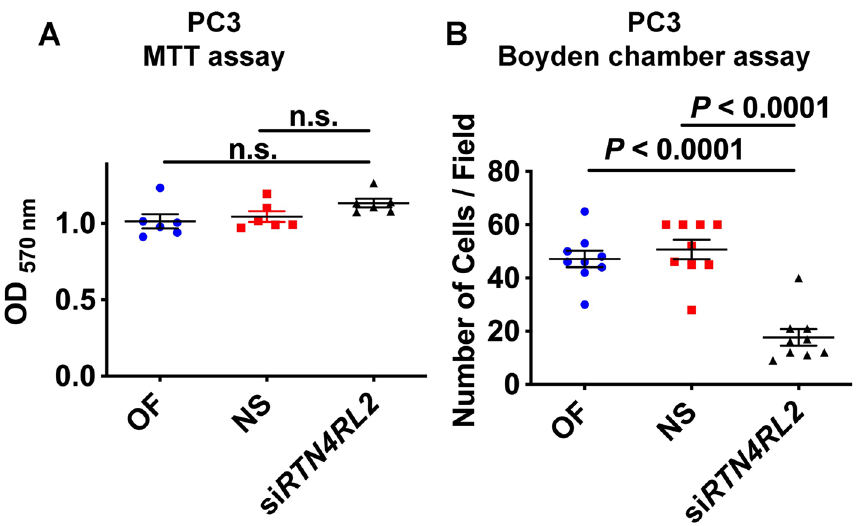
Figure 6. NgR2 modulates the motility but not the proliferation of PrCa cells. ( A ) PC3 cells, in which NgR2 expression was downregulated using a pool of siRNAs against RTN4RL2 (NgR2), were plated on 96-well plates (1 × 10 4 , n = 6) in complete media. After 24 h, the viability of PC3 cells was determined by MTT assay; values are reported as mean ± SEM. ( B ) The PC3 cells were also plated (5 × 10 4 , n = 3) on fibronectin-coated (10 µg/ml) Transwell chambers in serum-free media in both top and bottom chambers as previously described 4 . The dot plot represents the number of PC3 cells migrated in each treatment group towards the bottom chambers in 6 h (9 fields for each condition, field of view = 0.055 mm diameter). Values are reported as mean ± SEM; P -values were calculated by unpaired t-test using GraphPad Prism. OF, Oligofectamine; NS, non-silencing; n.s., non-